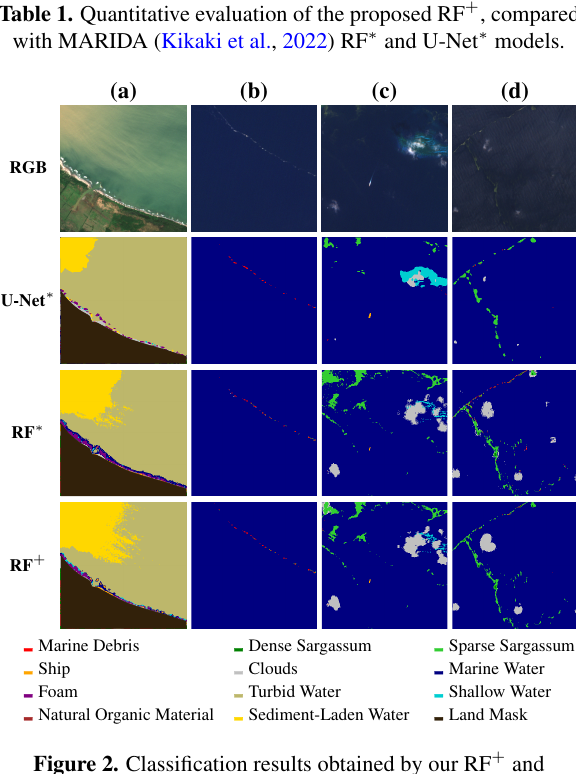
Figure 2. Classification results obtained by our RF + and MARIDA baseline (Kikaki et al., 2022) RF ∗ and U-Net ∗ models. (a) S2 12-12-20 16PCC 6, (b) S2 22-12-20 18QYF 0, (c) S2 27-1-19 16QED 14, (d) S2 14-9-18 16PCC